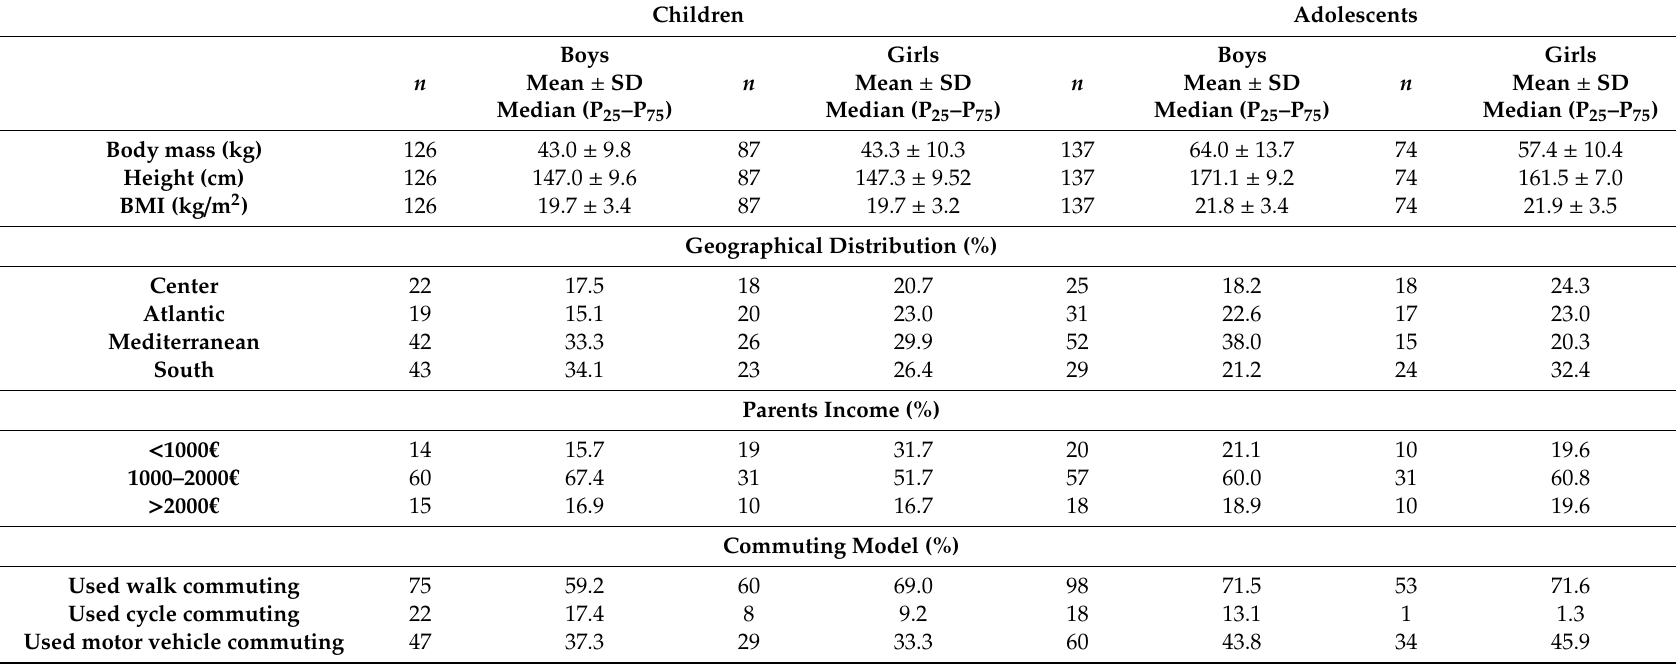
Table 1. Descriptive characteristics of the study sample by sex and age